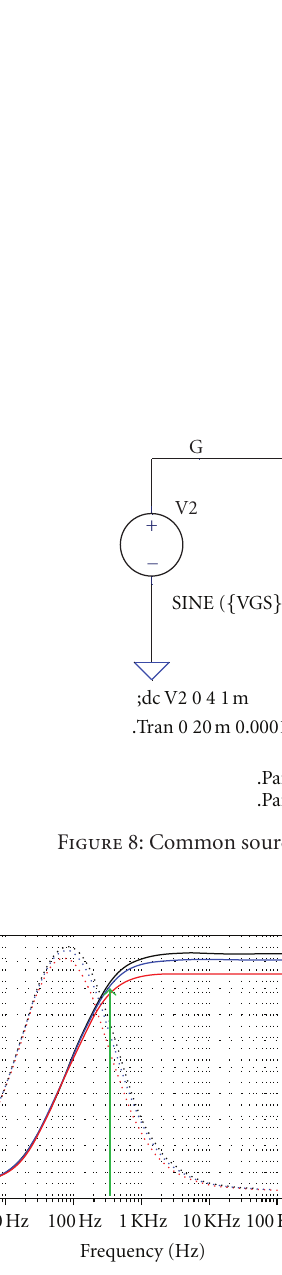
Figure 9: Gain verification. Output is measured from a 10 μ V input source as approximately 11, missing the design estimate of 12.5 by about 15%. The green arrow shows the 350 Hz − 3dB frequency. The upper 3dB (not shown) is much greater than the signal range of interest (approximately 10kHz). The curves show performance of variable V t in this configuration. Notice the gain has been stabilized to less than 3dB across a threshold variation of 1volt.